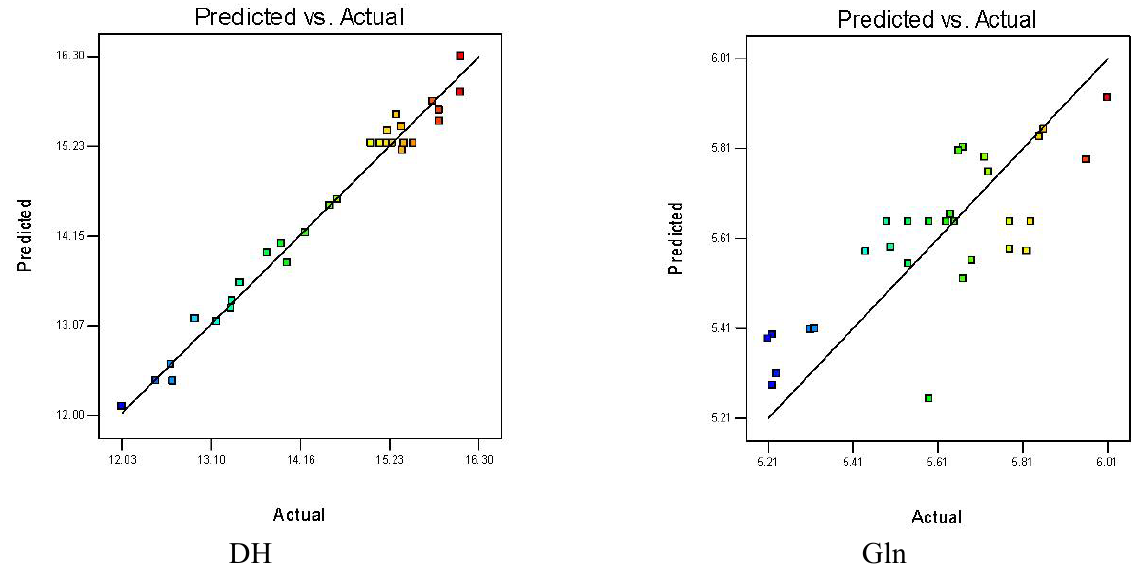
Figure 1. Predicted response vs. actual value for degree of hydrolysis (DH) and glutamine (Gln)